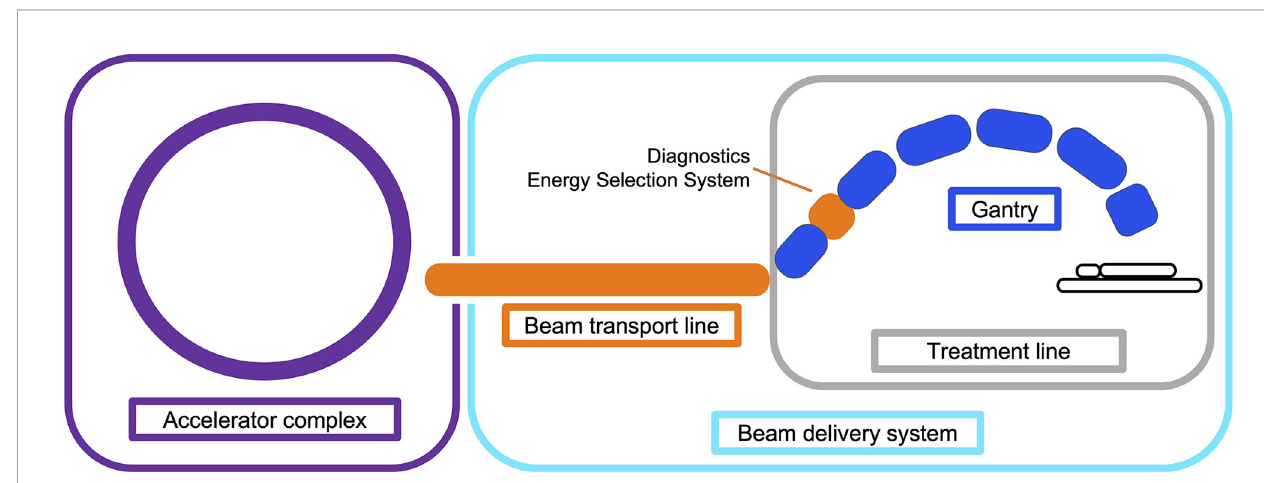
FIGURE 1 | Illustration overviewing the main components in a CPT treatment facility. The BDS is shown to include the BTL (beam instrumentation and devices which may alter the energy or shape of the beam) and treatment line ( fi xed line or here, a